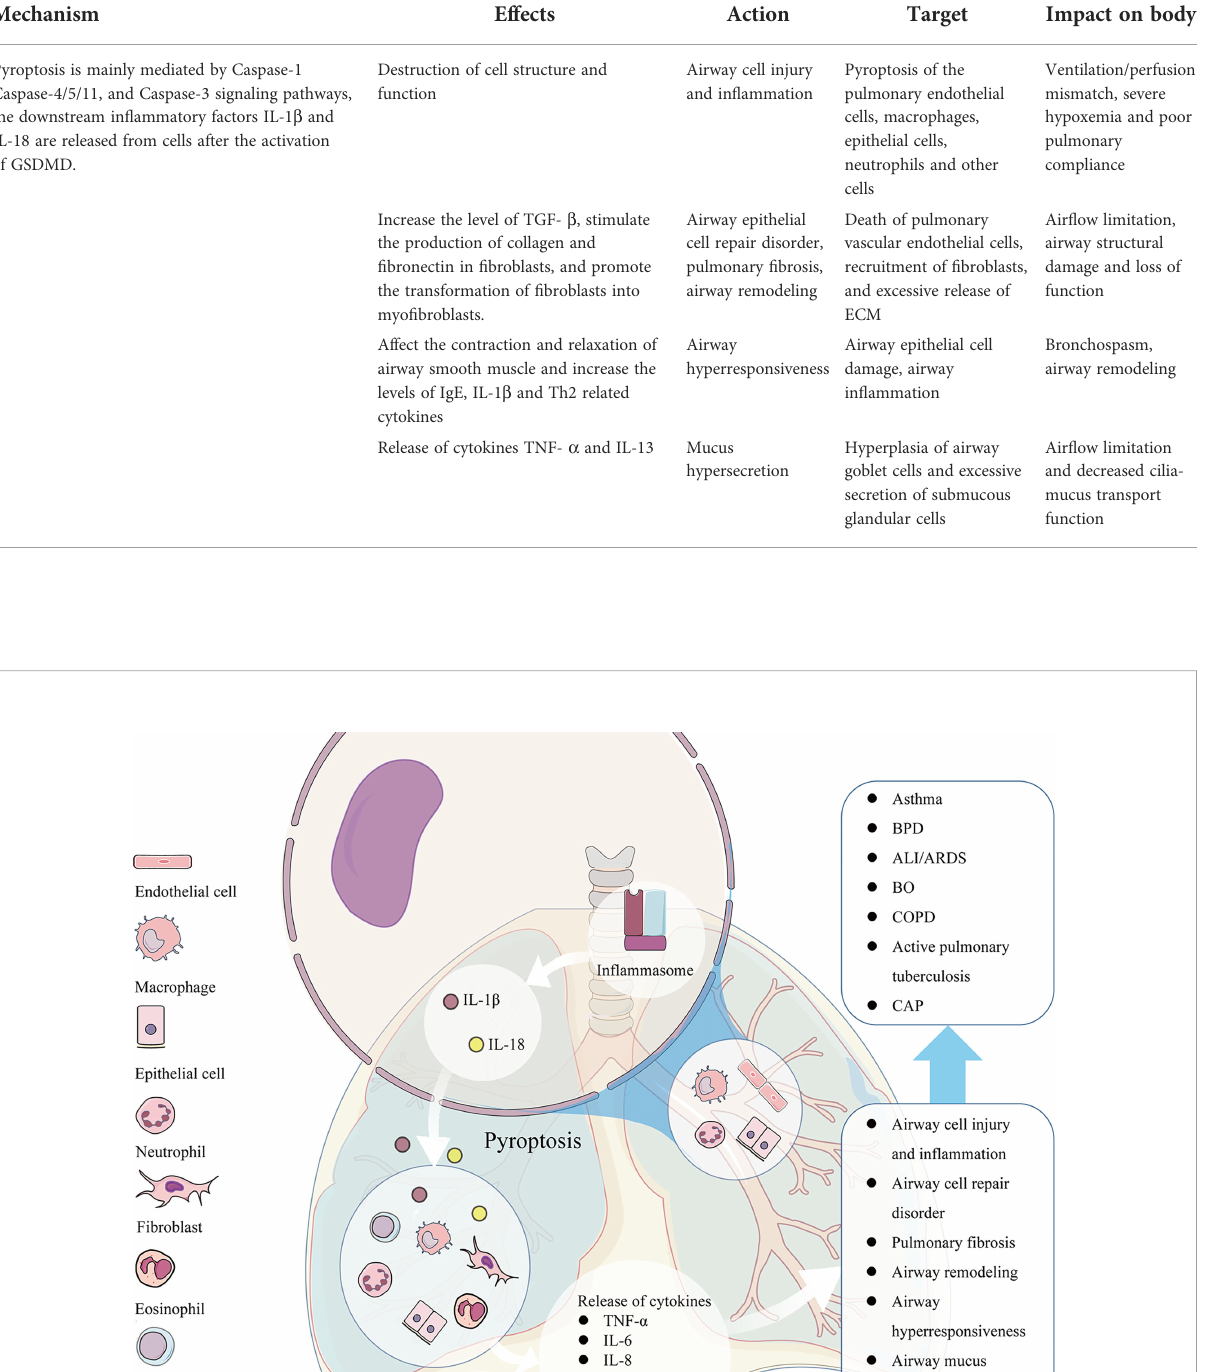
TABLE 1 The pathogenic mechanism of pyroptosis in airway